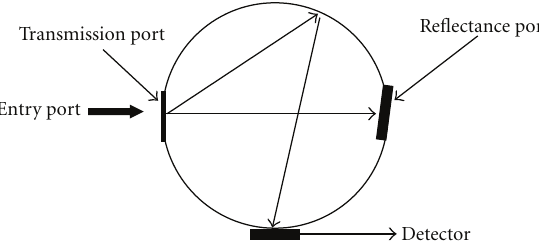
Figure 1: Schematic picture of the mechanism of light transmit- tance detection by spectrophotometer. Direct transmission can be seen traveling straight across the sphere to the reflectance port. Di ff use transmittance can be seen reflecting around the